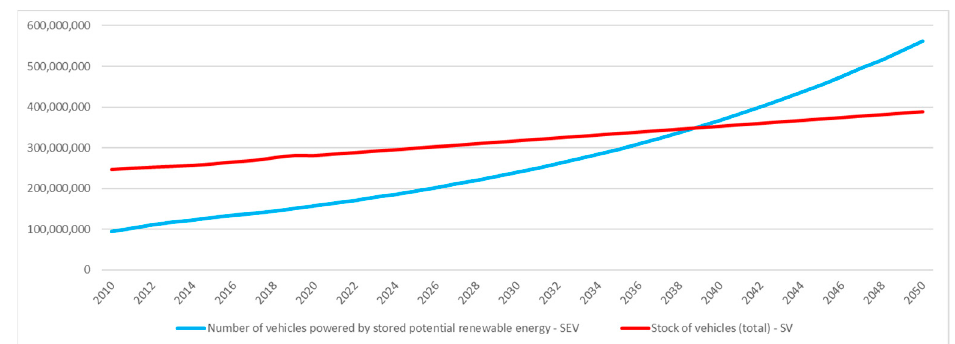
Figure 5. Comparative vehicle stock trends and the number of vehicles powered by stored potential renewable energy. Source: developed on data obtained using SPSS v.20.